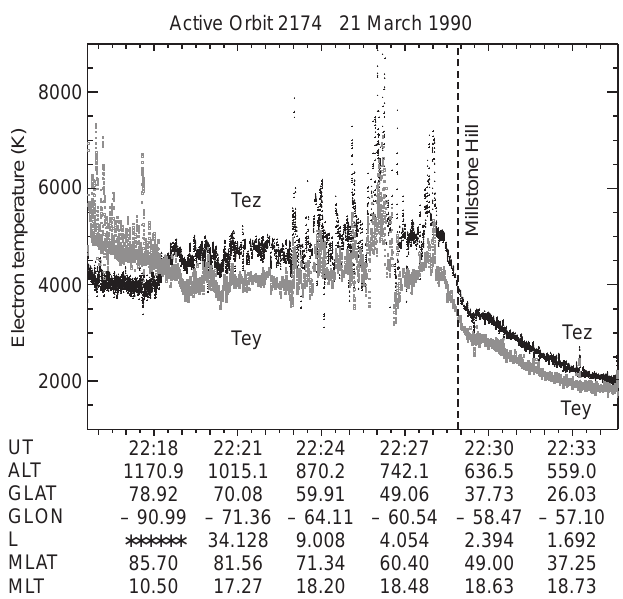
Fig. 6. Electron temperature measurements of the high frequency probe KM-6 along orbit 2174 of the Active main satellite on March 21, 1990 during its passage near the Millstone Hill station. T ez is the temperature component measured vertically upward; T ey is measured horizontally and perpendicular to the